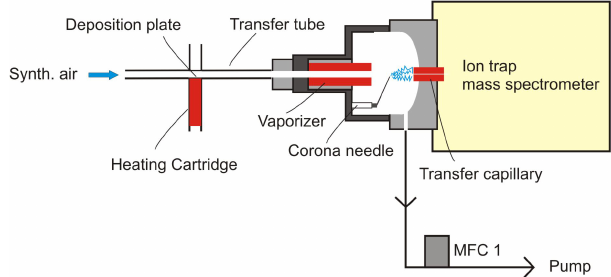
Fig. 2. Setup for the calibration of the APCI-IT-MS.